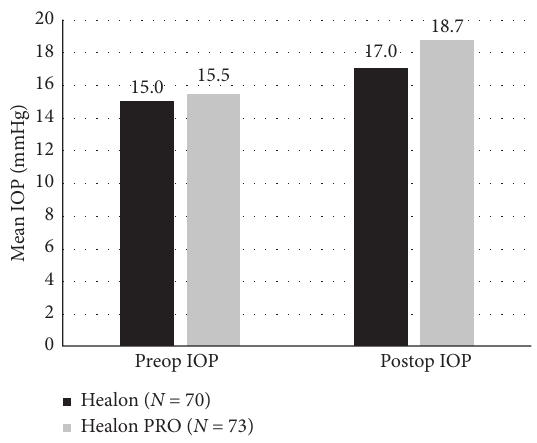
Figure 9: Mean change in IOP measured at baseline and at 1 day